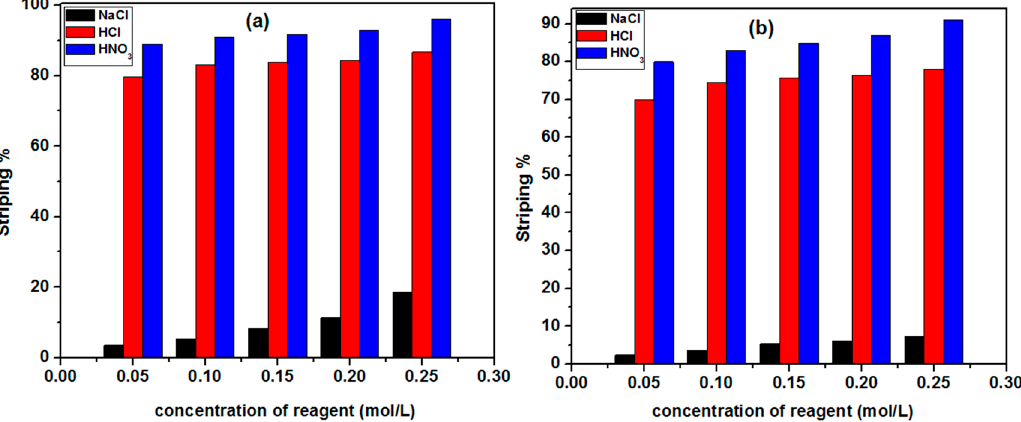
Figure 16. E ff ect of NaCl, HCl, and HNO 3 on stripping percentage of ( a ) U(VI) and ( b ) Th(IV) from HQ-bentonite.